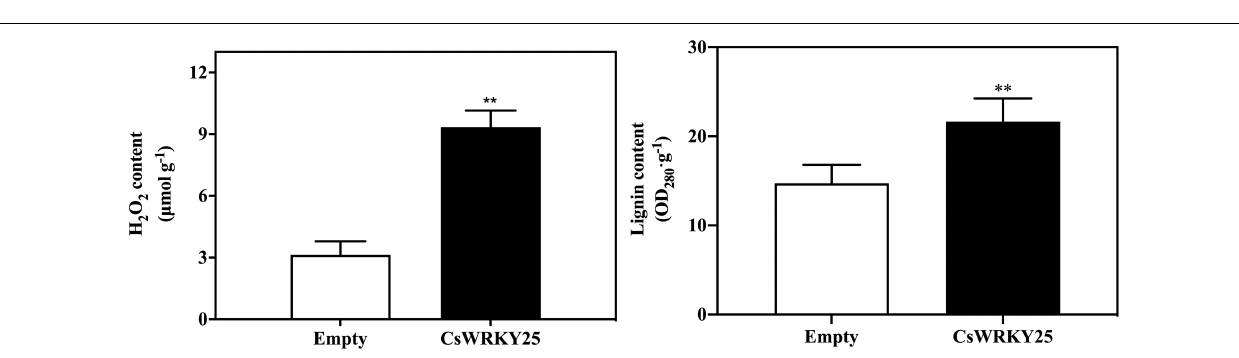
FIGURE 5 | Hydrogen peroxide (H 2 O 2 ) and lignin content in citrus fruit peel with the transient overexpression of CsWRKY25 . The H 2 O 2 and lignin content are determined by fresh weight. Values equal the mean ± SE. P values were regarded as statistically significant at ** P <